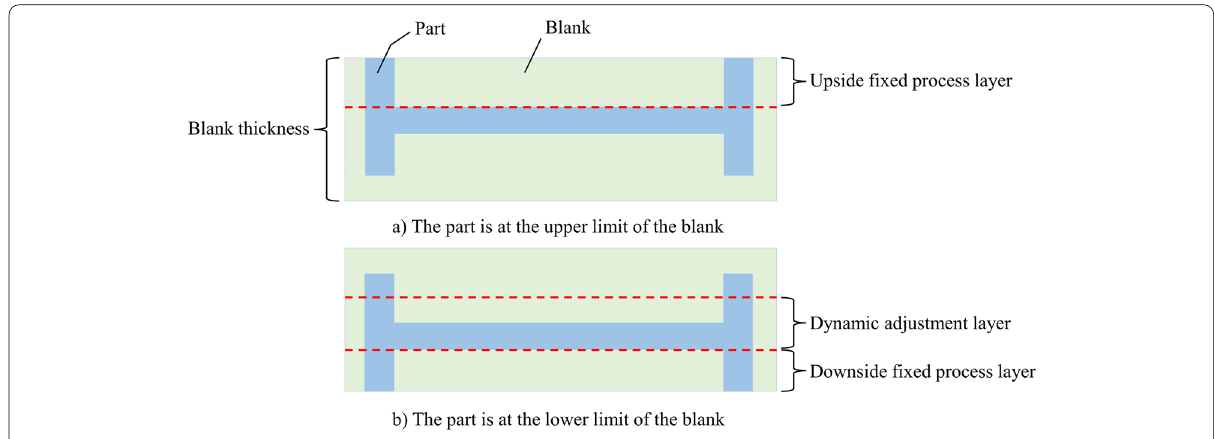
Fig. 5 The layering diagram of a